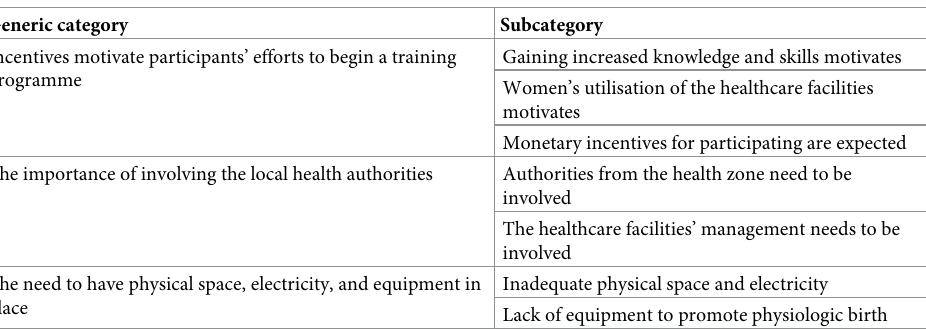
Table 4. Categories and subcategories describing contextual factors influencing the three-pillar training